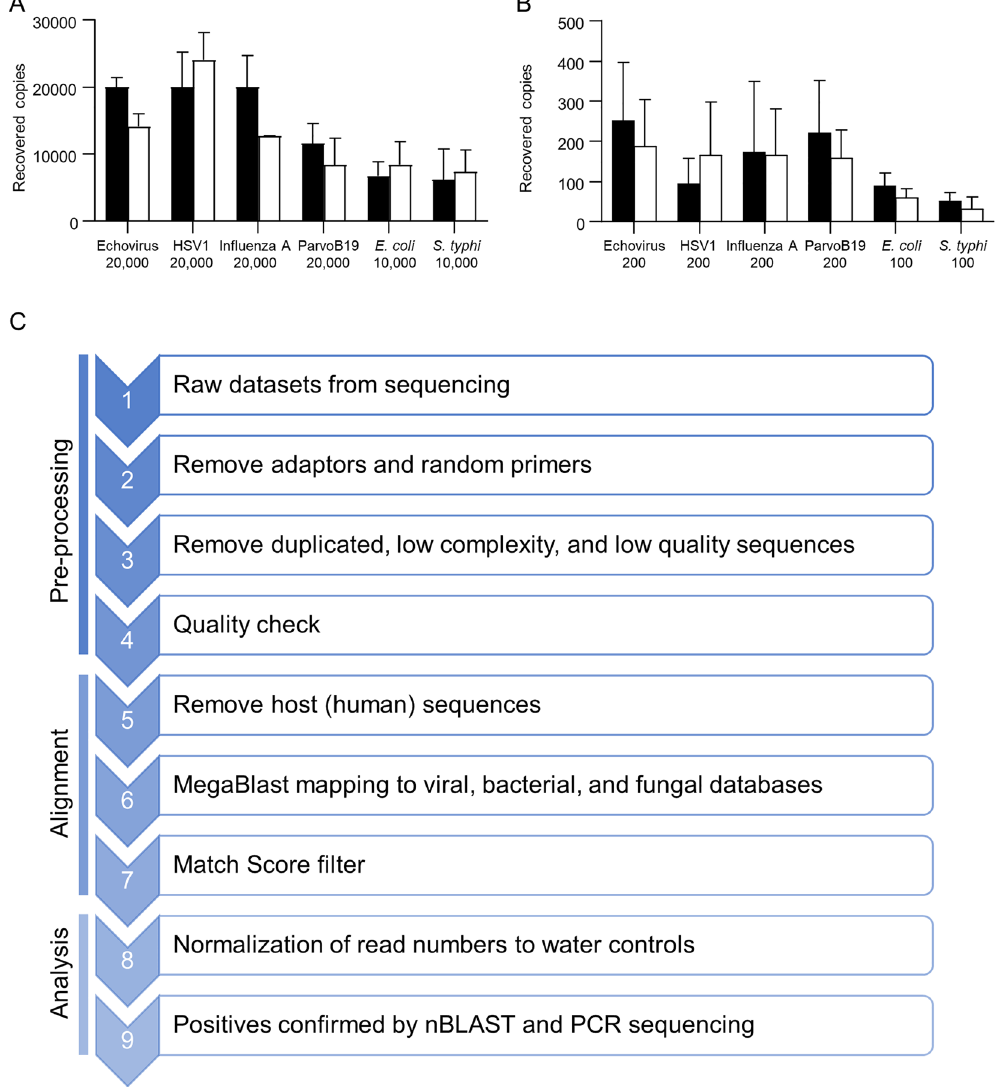
Figure 1. Viral and bacterial genome copy yield from human amniotic fluid by extraction method. ( A,B ) Recovered copies for various pathogens and spike levels as indicated on the x axis for the MinElute (black bars) and PureLink (white bars) columns. Error bars represent SD for 3 experiments. ( C ) Overview of the metagenomic method